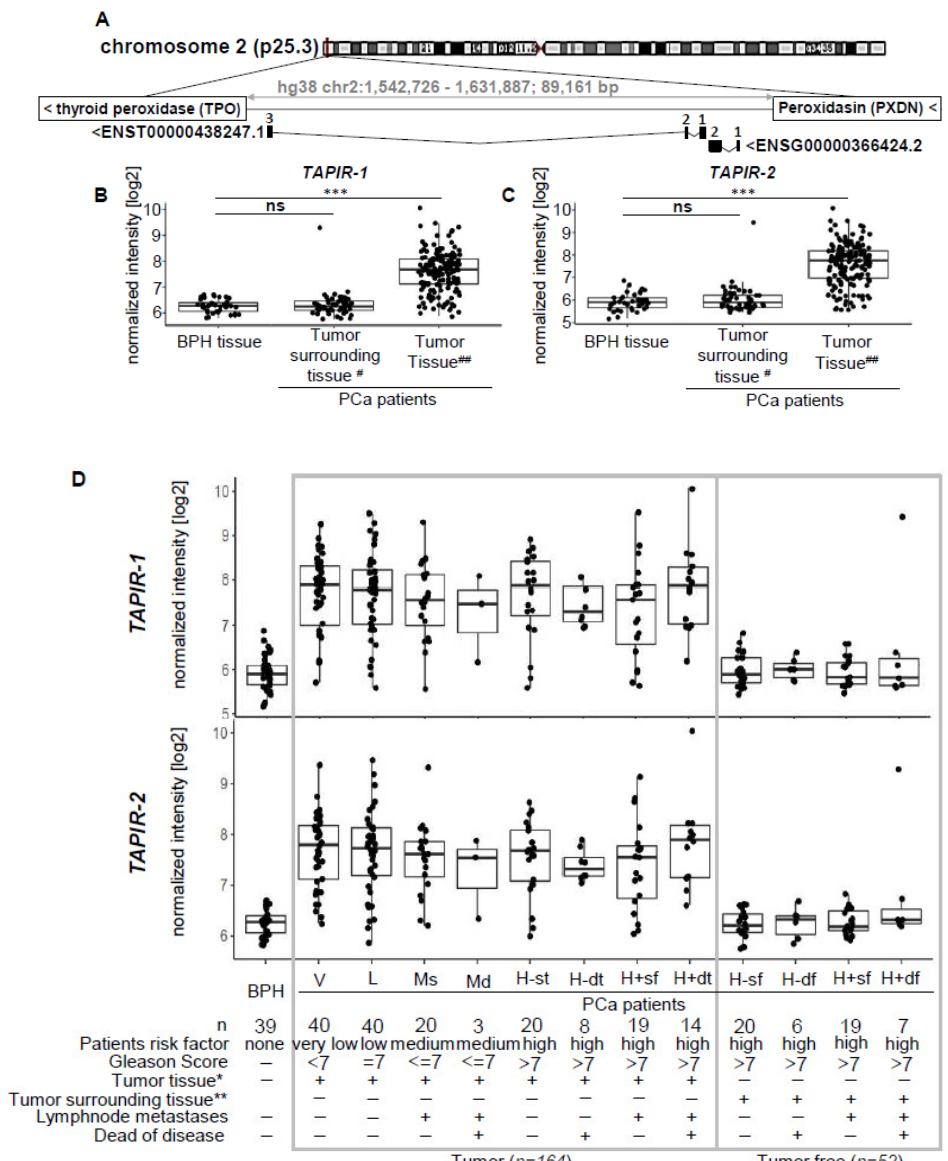
Figure 1. Expression analysis of the lncRNAs TAPIR-1 and -2 shows significant overexpression in prostate cancer tissue. ( A ) Schematic representation of the chromosomal location of the TAPIR-1 and TAPIR-2 gene locus and intron exon transcript structure. Exons are represented by numbered black boxes, introns by black lines. ( B , C ) Box plot analysis for the lncRNAs TAPIR-1 ( B ), TAPIR-2 ( C ), measured by Agilent custom expression microarrays of the validation cohort only (tumor tissues from 124 PCa patients and control tissues from 39 BPH patients). The results of the exploratory cohort are shown in Figure S1. ( D ) Expression patterns of TAPIR-1 ( D ), and TAPIR-2 ( B ) determined using microarray analyses are shown related to clinical risk classification. Normalized expression intensity [log2] was plotted against subgroups based on clinical data sets: patient risk factor (none, very low, low, and high); Gleason Score (none, =7, ≤ 7, >7); tumor tissue (-/+), verified tumor cell content >60% for tumor tissue (denoted with *; -/+); matched tumor adjacent tissue (-/+), verified tumor cell content 0 – 5% for matched tumor surrounding tissue (denoted with **; -/+); lymph node metastases (-/+), died of disease (-/+). Groups are defined as follows: BPH, PCa-risk groups: V = very low; L = low; Ms = medium, with lymph node metastases; Md = medium, with lymph node metastases and death because of disease (DoD); tumor tissue (t): H-st = high, without metastases; H-dt = high, without